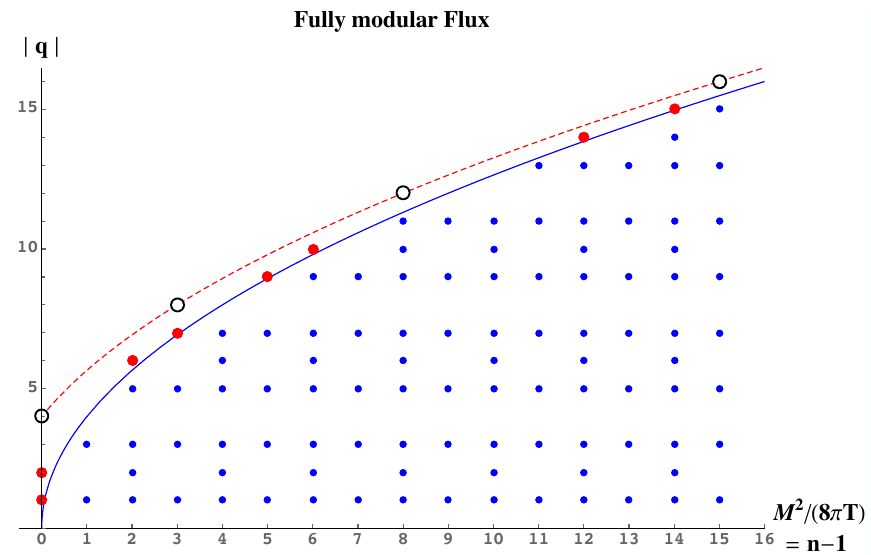
Figure 1 . Shown is the charge-mass spectrum encoded in the fully modular elliptic genus (5.22). The fat red dots indicate super-extremal states, which lie above the solid blue line encoding the charge-to-mass ratio of classical extremal black holes as discussed in section 6.3. Note the gaps at charges q = 4 Z ; in particular the open dots, which would correspond to the possible maximal super-extremal states and which would form a charge sublattice by themselves, are not populated. Qualitatively this picture does not only apply to the present example, but to the generic situa- tion with modular (cid:13)uxes. We will come back to it in the next section in the context of Weak Gravity